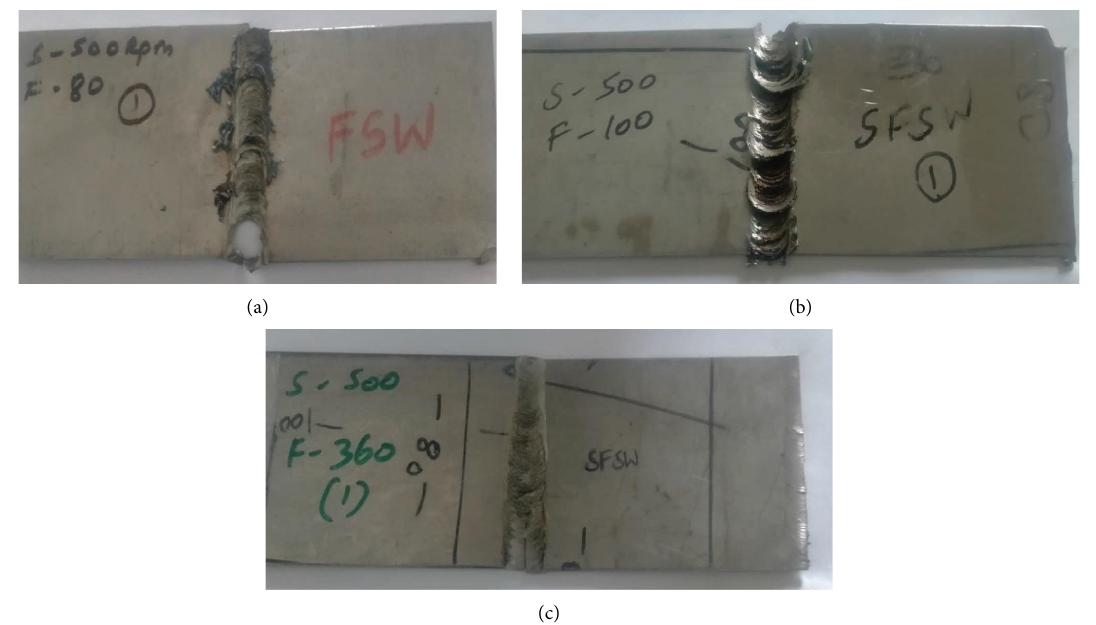
Figure 4: Defects observed. (a) Burnt efect in air. (b) Burnt efect in water. (c) Incomplete flling in SFSW.